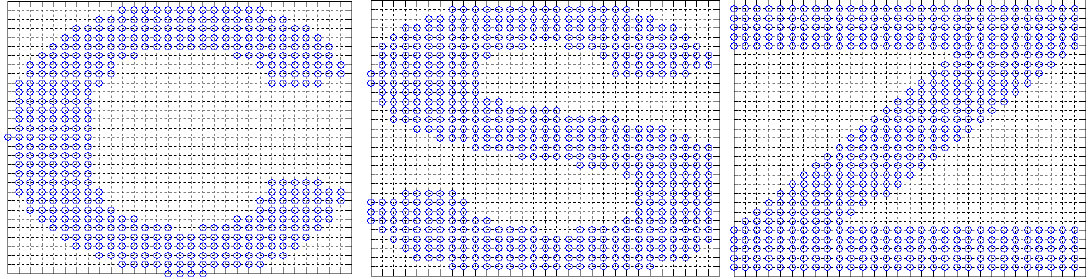
Figure 5. The regular distribution of nodes.